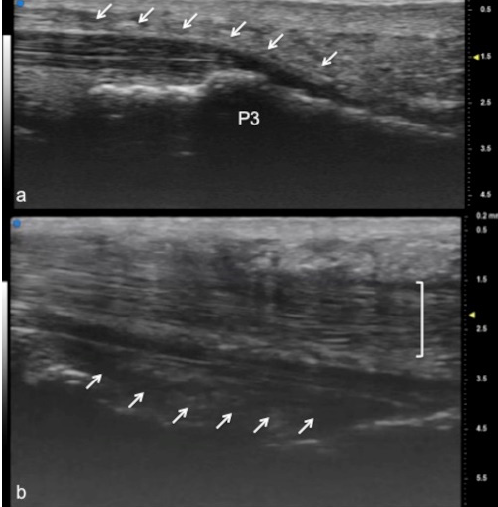
Figure 3. Flexor tendon of a finger. Using UHFUS at the flexor tendons, the same spatial resolution can be achieved as in the imaging of the extensor tendons. In ( a ), the sagittal view of the deep flexor tendon component inserting on the basis of the distal phalanx (P3). In ( b ), the superficial component of the flexor tendon (white arrows) lying near the deep component (white square parenthesis).